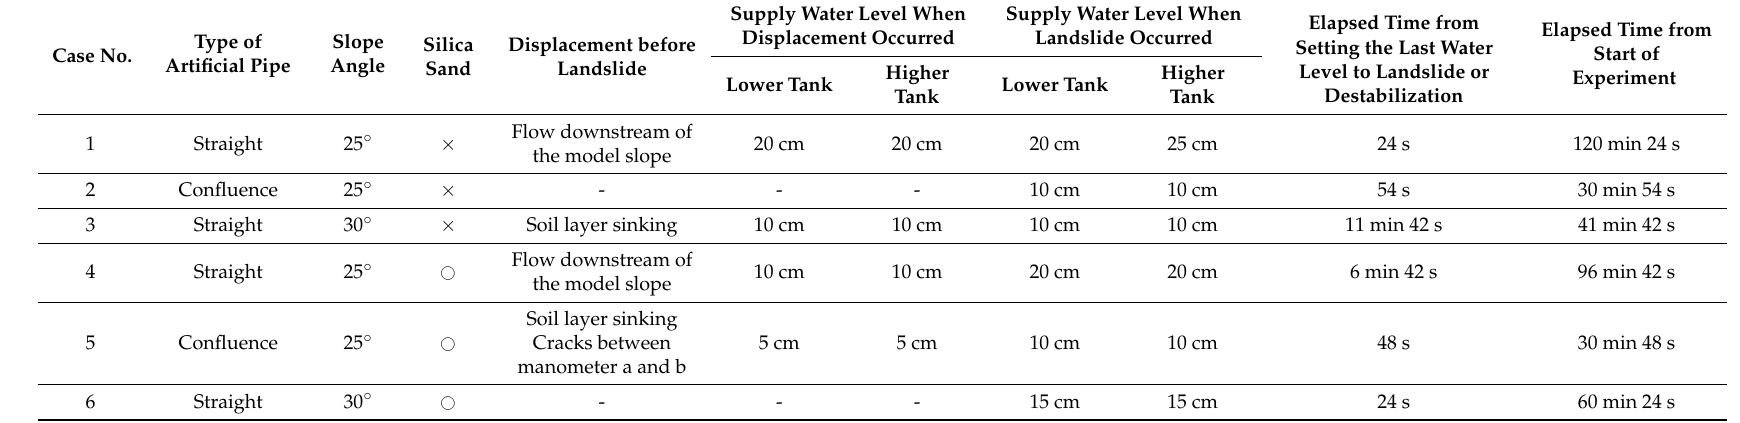
Table 1. Experimental conditions and water supply level when each landslide occurred, the elapsed time and the time at which the landslide took place after the water level was raised. Circles indicate that the case included silica sand, and crosses indicate that silica sand was layered on the model slope.